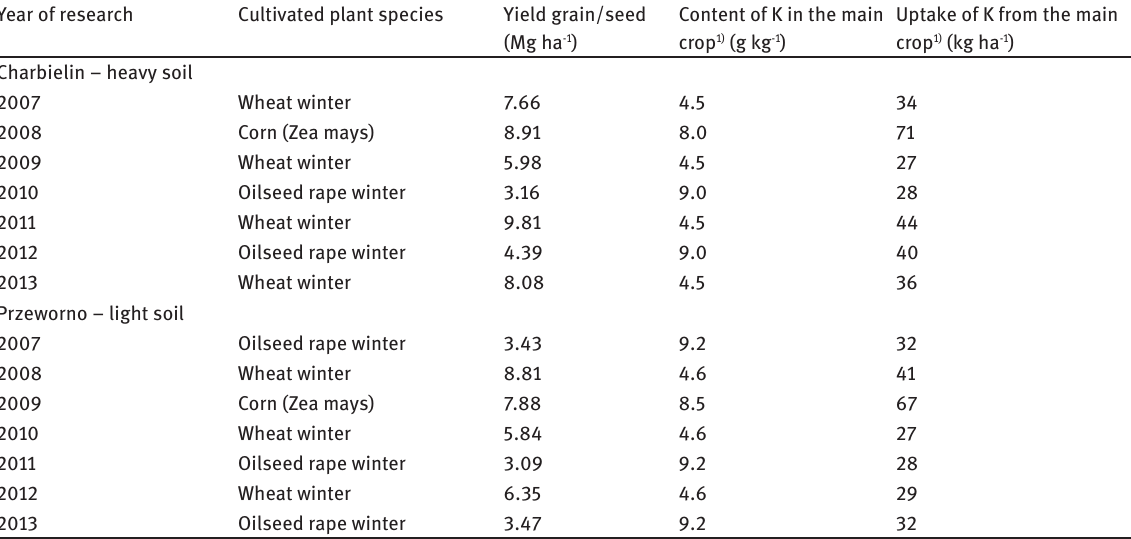
Table 3: Cultivated plant species, crop yield, content and uptake of